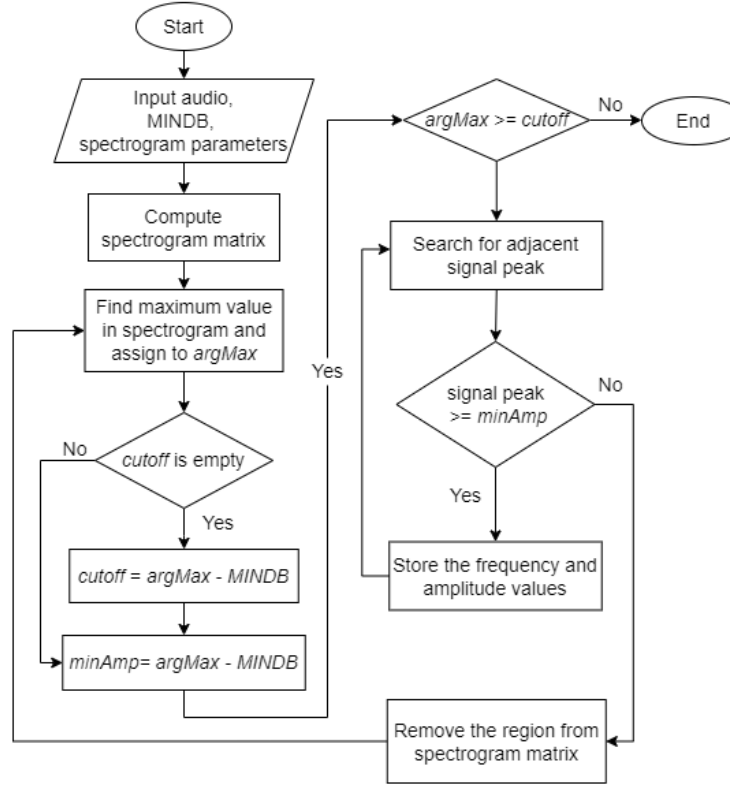
Figure 6. Flowchart of the Härmä syllable segmentation algorithm.